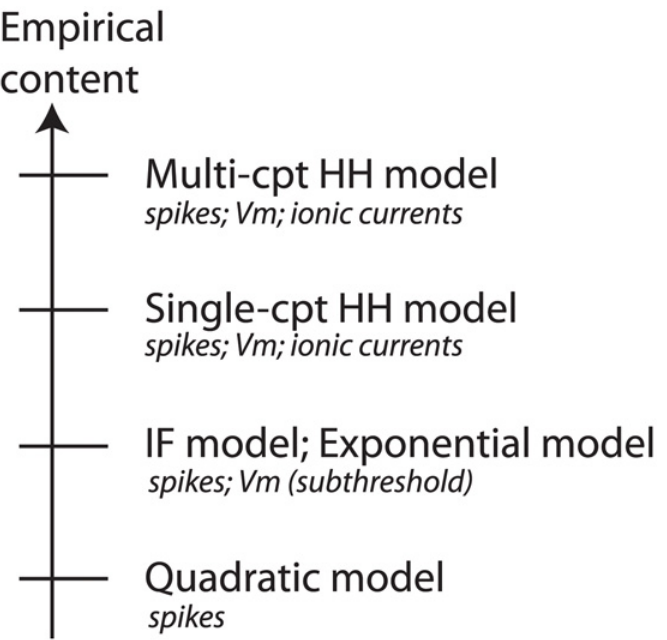
Fig 2. Empirical content of models, from the quadratic model (only spike trains are predicted) to multi- compartmental HH models (Membrane potential and ionic currents are predicted at different locations on the